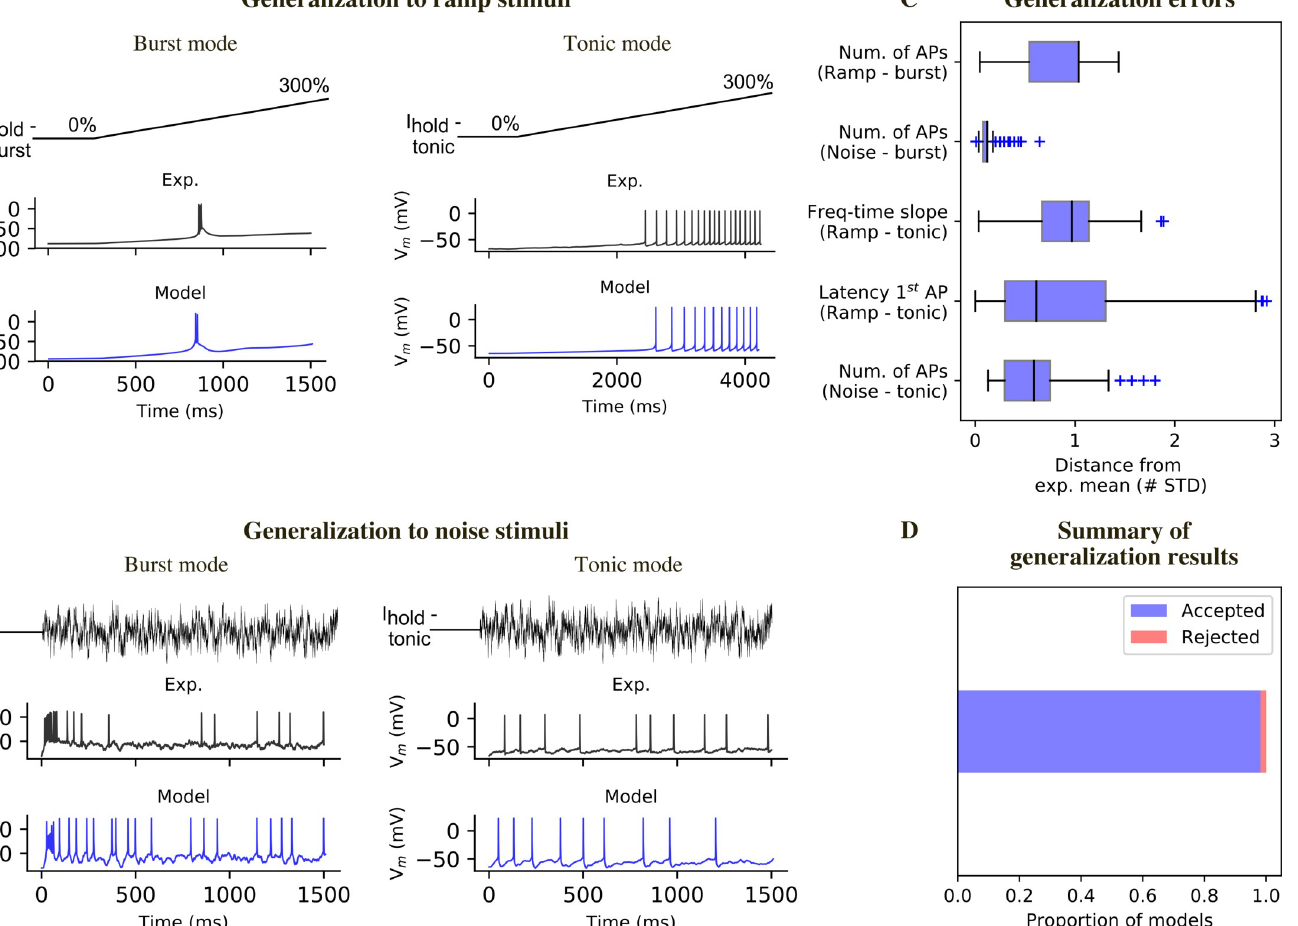
PLOS Computational Biology | https://doi.org/10.1371/journal.pcbi.1006753 May 16,